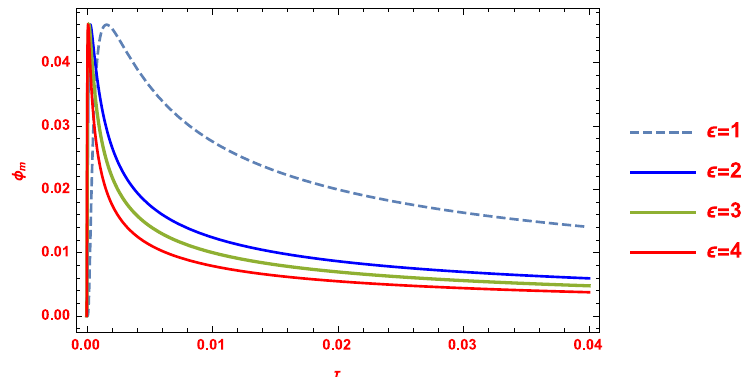
Figure 11. φ m varying along τ for different We .